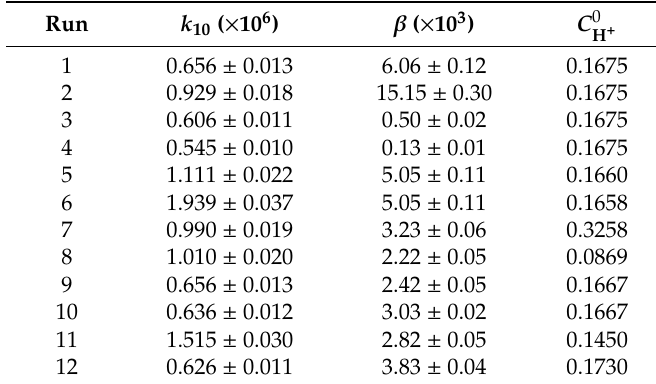
Table 4. Kinetic parameters and initial protonic concentration used for simulating the ring opening reaction (ROR) runs performed in the presence of sulfuric